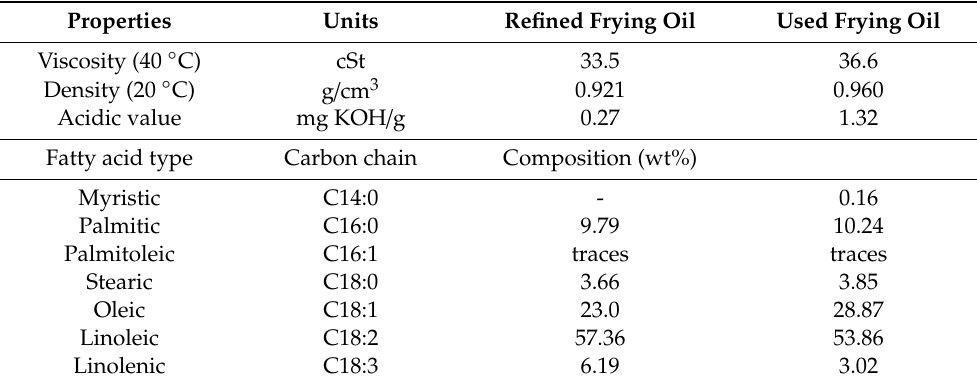
Table 1. Physical properties and fatty acid methyl esters composition of refined and used frying oils.